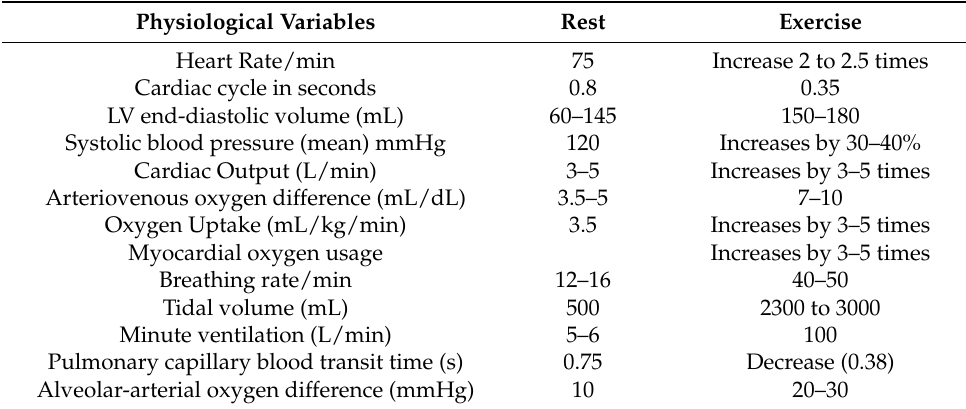
Table 1. Comparison of Cardiopulmonary variables at rest vs. exercise. Physiological